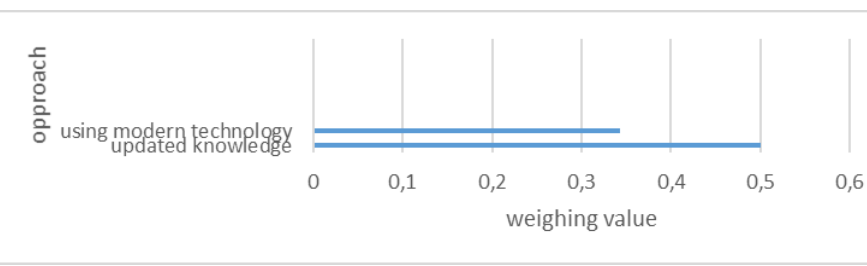
Figure 11: Result of technical approach criteria weighing value (Inconsistency ratio=0.01)